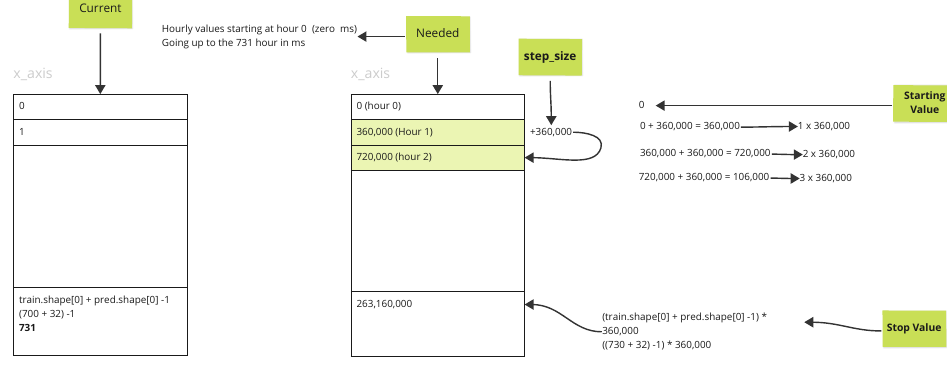
Figure 13. The predictive computation.